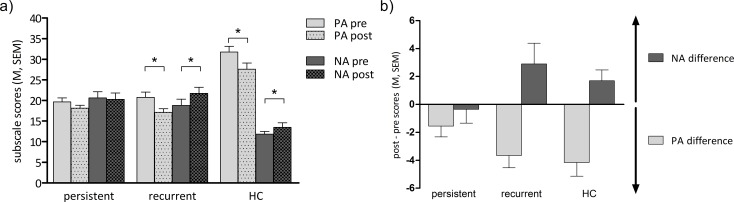
Affective reactivity.a) Group mean subscale scores with SEM for positive (PA) and negative affect (NA), pre and post mood induction, respectively. b) Difference scores (post-pre scores) for PA and NA per group. The greater the increase of NA as well as the decrease of PA, the higher the affective reactivity. persistent = patients with persistent depression, recurrent = patients with recurrent depression, HC = healthy comparisons. Asterisks indicate significant with-in group differences (* p < .05, Bonferroni corrected).